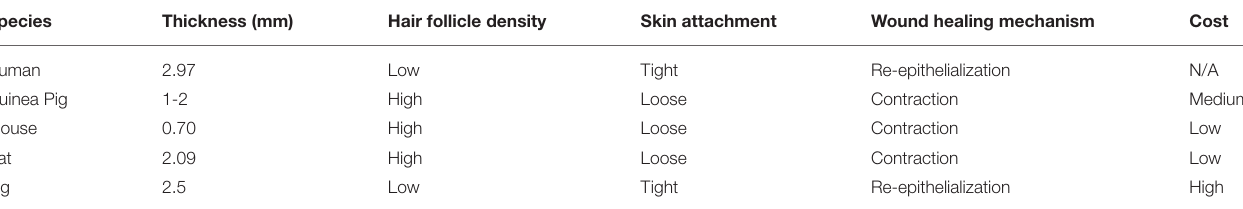
TABLE 1 | Comparative properties and cost of in vivo wound healing models (Godin and Touitou, 2007; Gainza et al., 2015; Summerfield et al., 2015). Species Human Guinea Pig 1-2 Loose Mouse 0.70 High Loose Low Pig 2.5 Low Tight